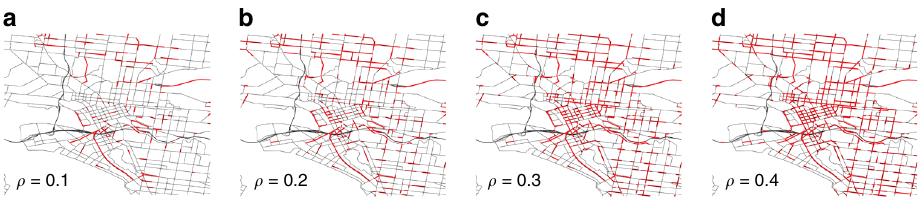
Fig. 1 Spatial distribution of congestion in the Melbourne network. At a given time t = 8:30 a.m. maps indicate the congested links (coded red) on the network when a ρ = 0.1, b ρ = 0.2, c ρ = 0.3, and d ρ